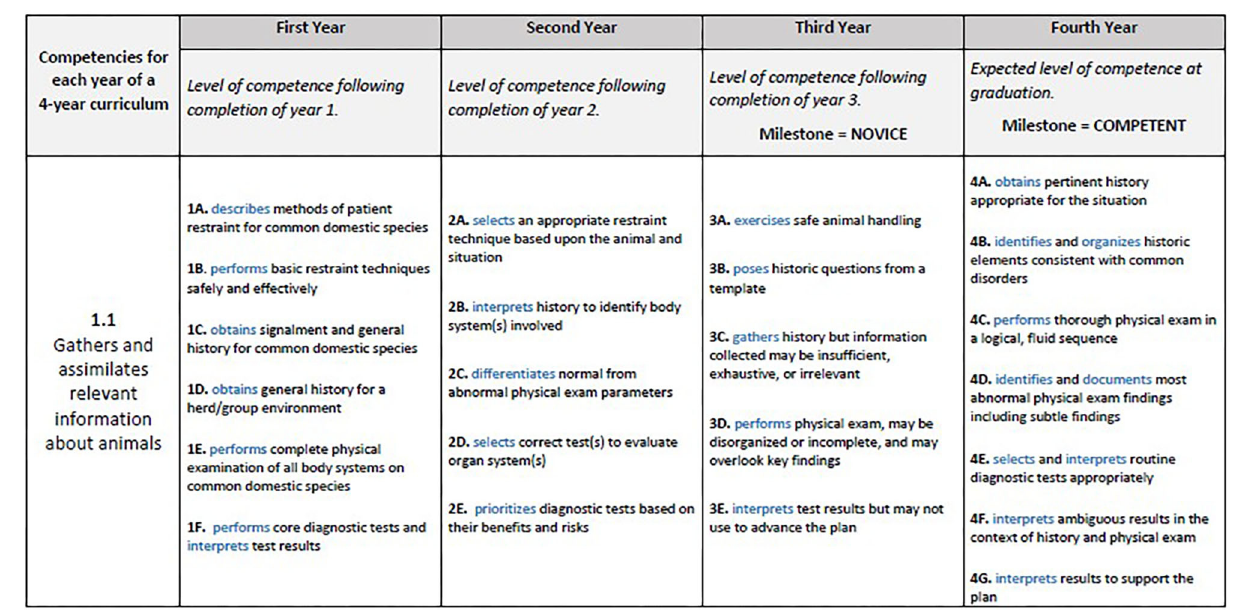
FIGURE 2 | Clinical and preclinical milestones for CBVE Competency 1.1, Gathers and assimilates relevant information about